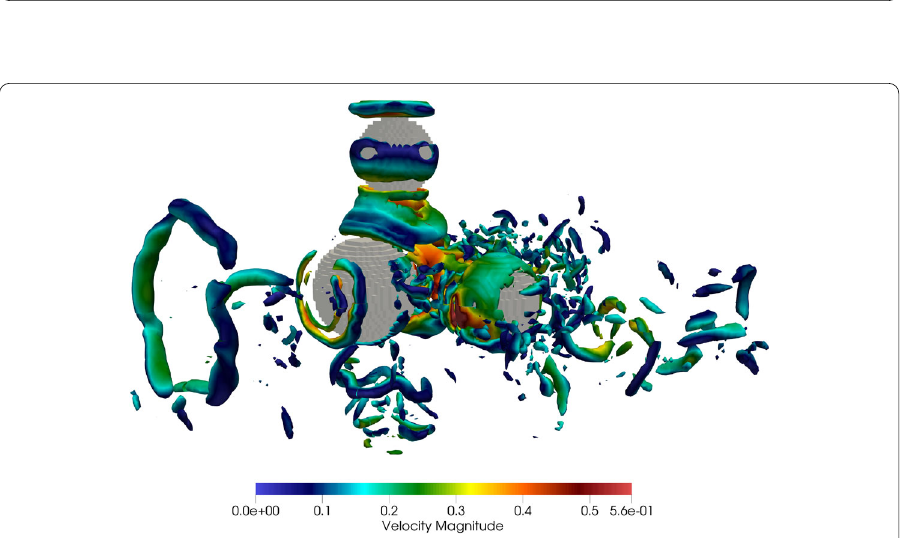
Fig. 17 Contour plot showing the Q-criterion of 7 . 0 after 9 . 6 s simulation time. The contours are coloured by the velocity